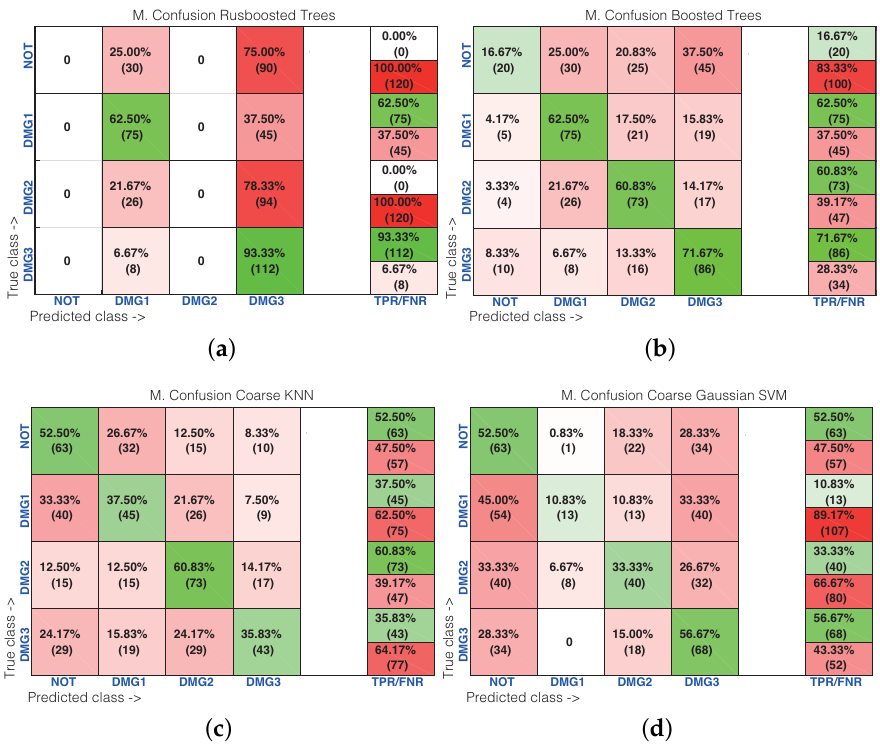
Figure 24. Confusion matrix machines with bad behavior. ( a ) Rusboosted trees; ( b ) boosted trees; ( c ) coarse k -NN; ( d ) coarse Gaussian